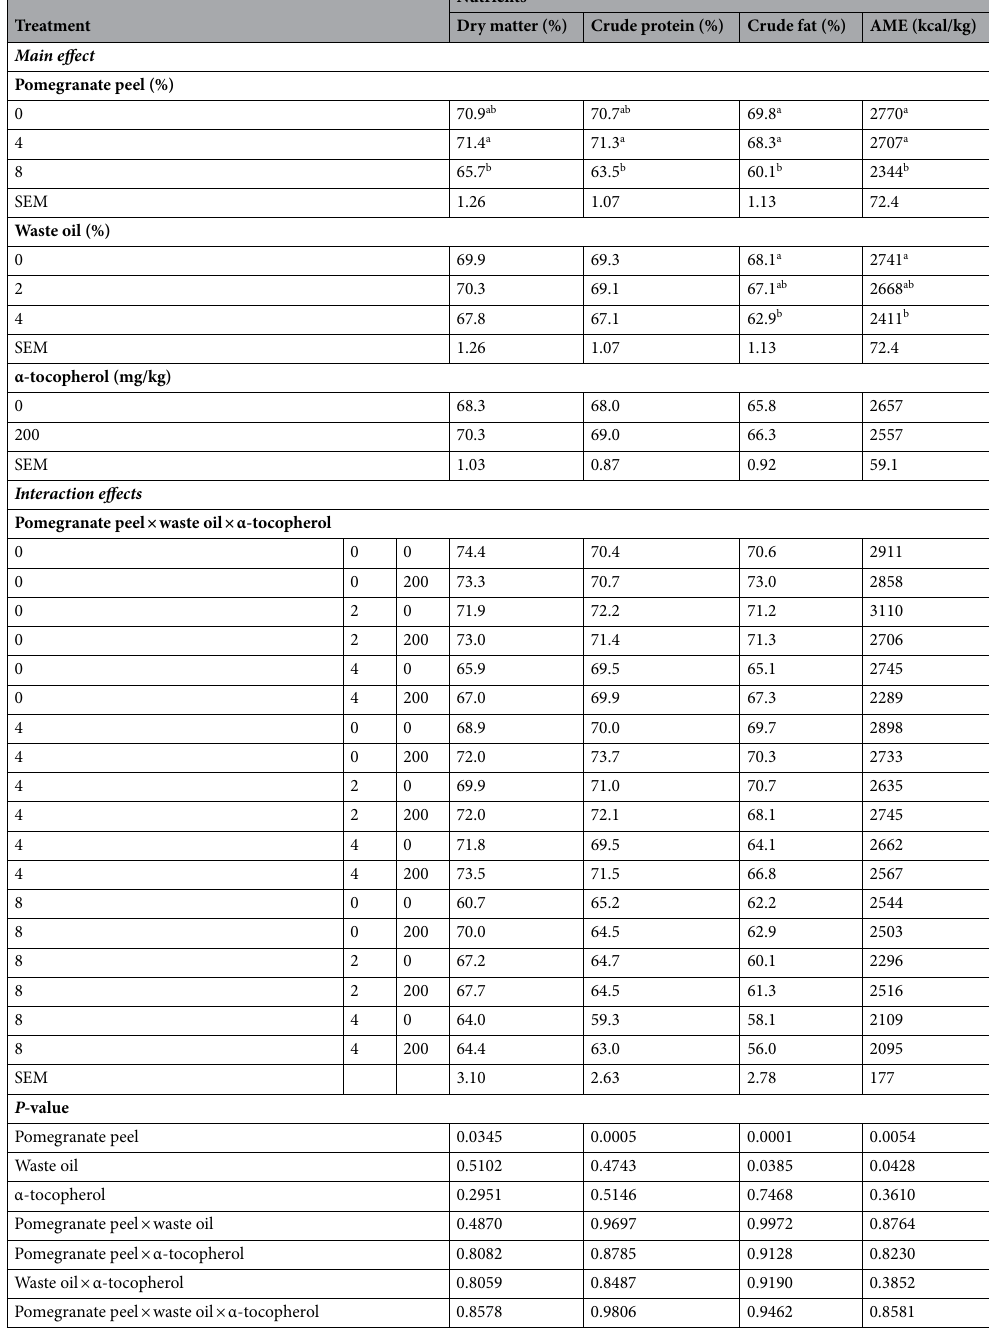
Table 7. The effects of using pomegranate peel, waste oil and α-tocopherol in diets on apparent nutrient digestibility and AME in broiler chickens. SEM standard error of mean, P-value probability values. a :b Means in columns with the same superscript do not differ significantly P <